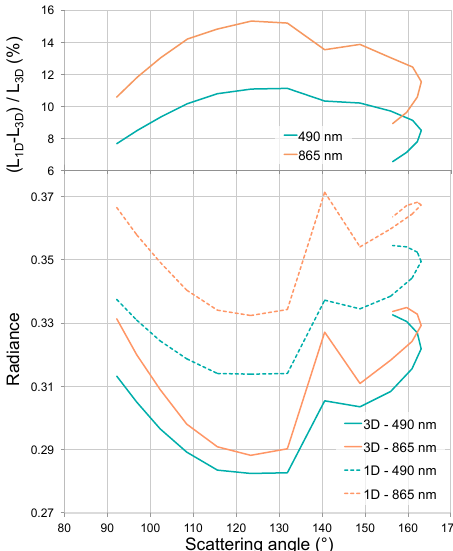
Figure 12. Simulated radiances for aerosols above a heterogeneous cloud ( σ (COT) / COT = 0.6) at 490nm (green lines) and 865nm (orange lines) for a solar zenith angle of 40 ◦ . 3-D signals (contin- uous lines) have been obtained from the 3DMCPOL code and are based on a cloud field modeled with